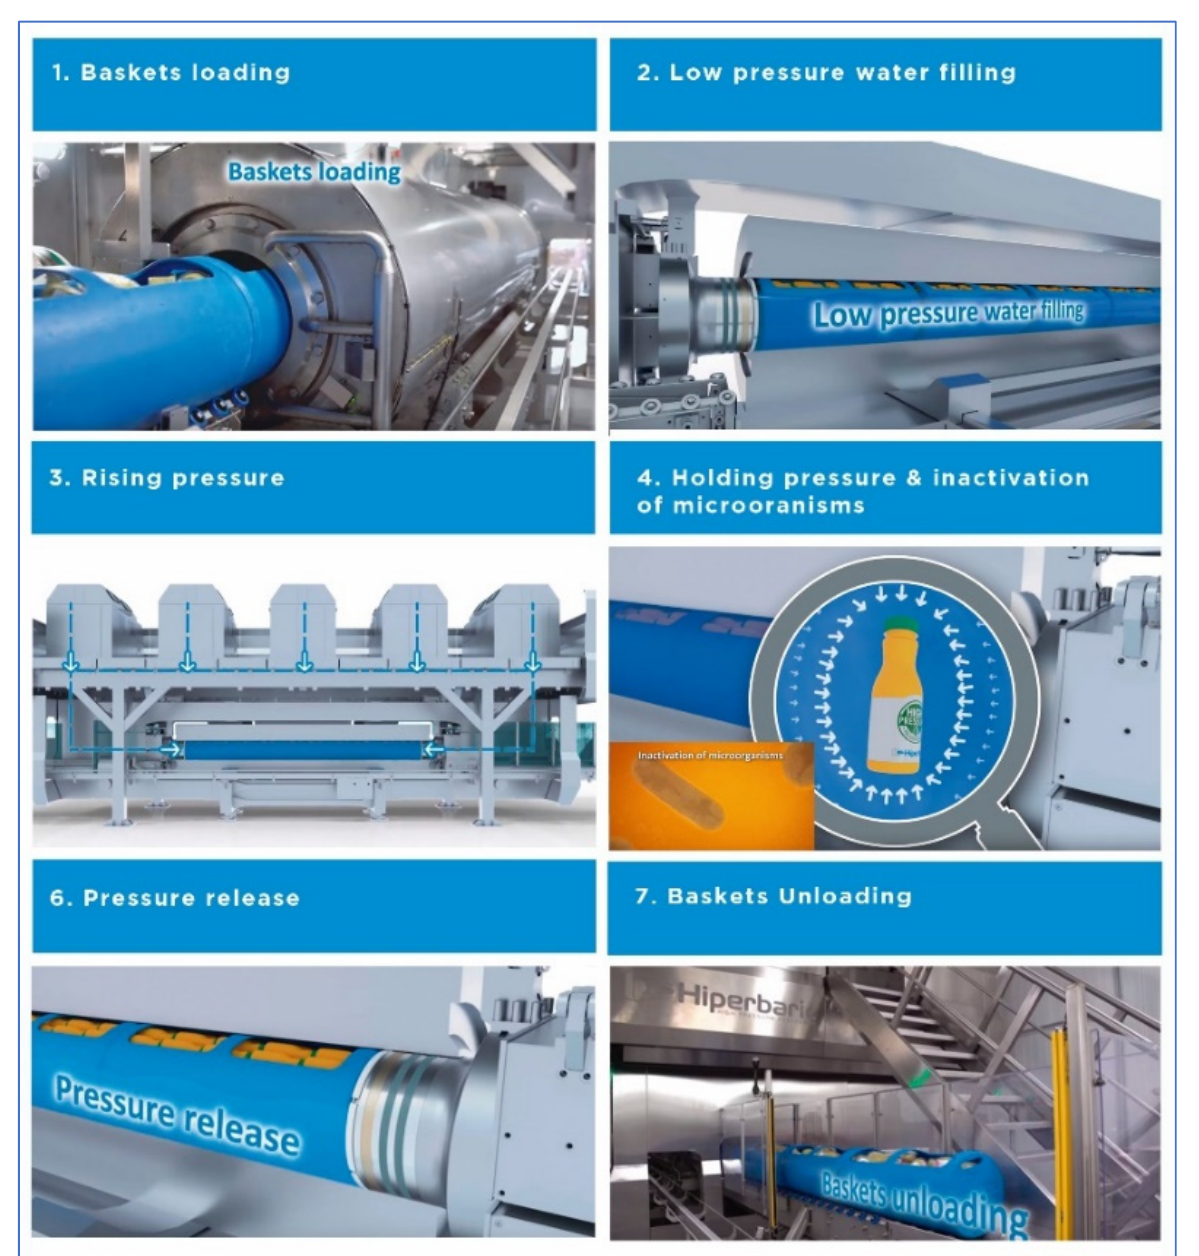
Figure 3. HPP in-pack processing sequence.